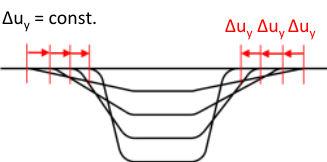
Figure 10. Forming sequence with constant bending angle increase in each roll pass. • Constant material inlet increase (Figure 11).